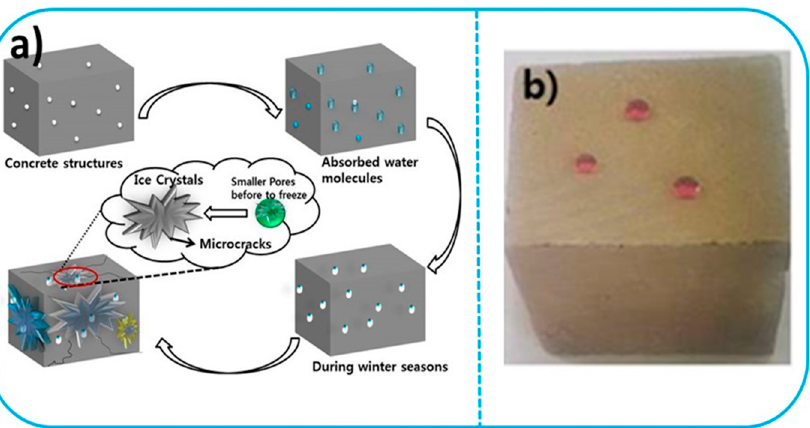
Figure 13. Schematic diagram of the mechanism of crack formation in concrete ( a ); Incorporation of hydrophobic materials admixed in concrete ( b ) [255] .